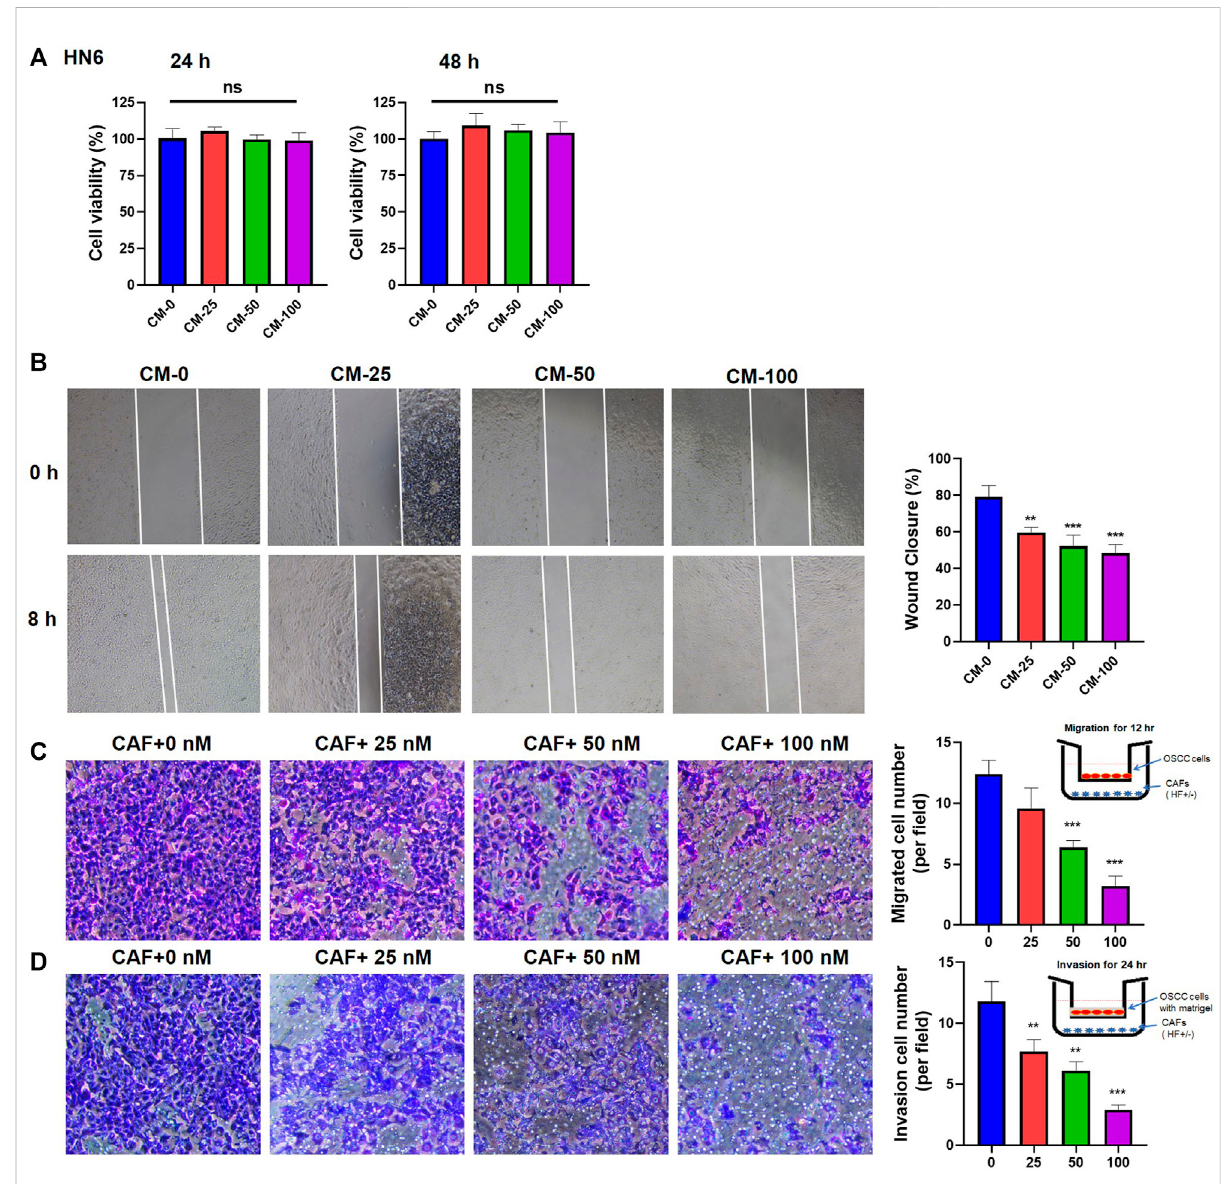
FIGURE 4 EffectsofHF-treatedCAFsontheproliferation,migration,andinvasionoftumorcells. (A) CMhadnoeffectontheproliferationofHN6cells. (B) CM treated with high-concentration (100 nM) HF could signi fi cantly inhibit the migration of HN6 cells (100×). Transwell experiments showed that HF-treated CAFs signi fi cantly inhibit tumor migration (C) and invasion (D) . *: p < 0.05, **: p < 0.01, ***: p <